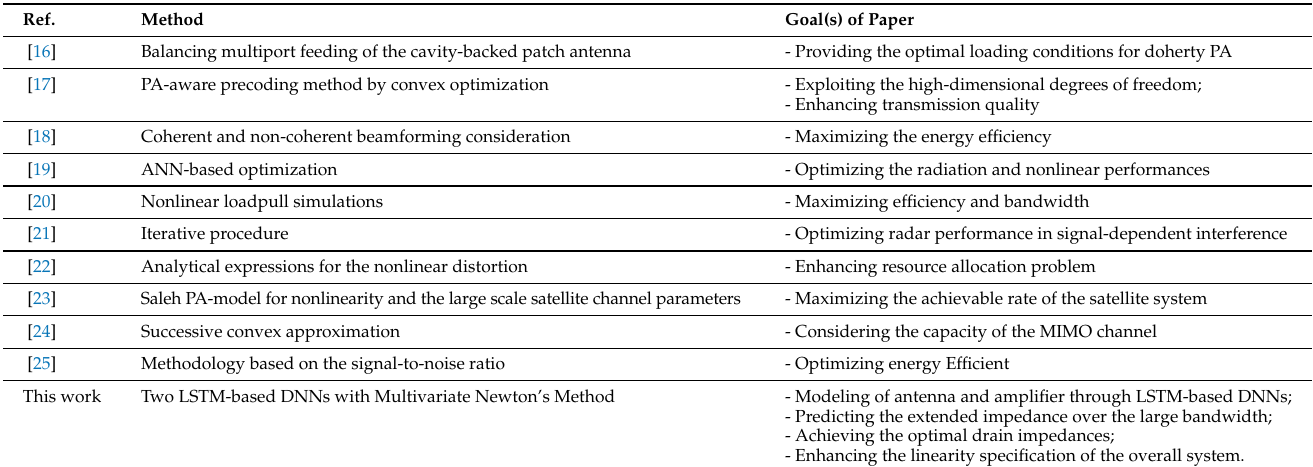
Table 4. Summary of various methodologies employed for hybrid design of antennas with amplifiers in recent